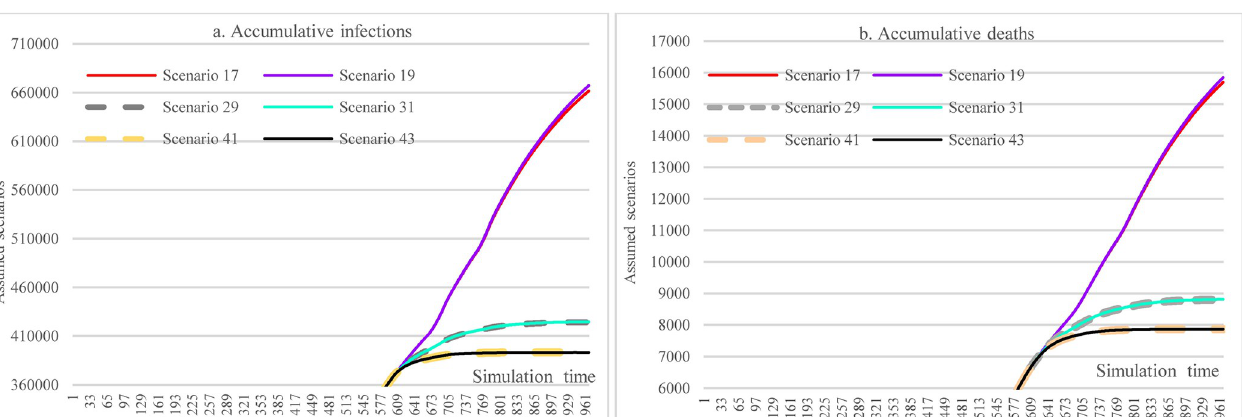
PLOS ONE | https://doi.org/10.1371/journal.pone.0271231 July 26,